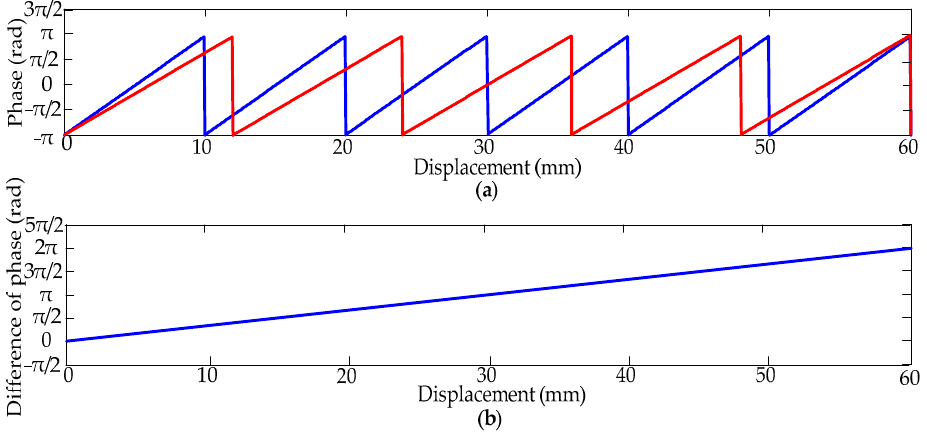
Figure 3. ( a ) Phase of outputs of row 1 ( U row 1 ) and row 2 ( U row 2 ) within their periods W row 1 and W row 2 , respectively, versus the displacement of the induction electrode array. ( b ) Phase difference with respect to the displacement of the induction electrode array.